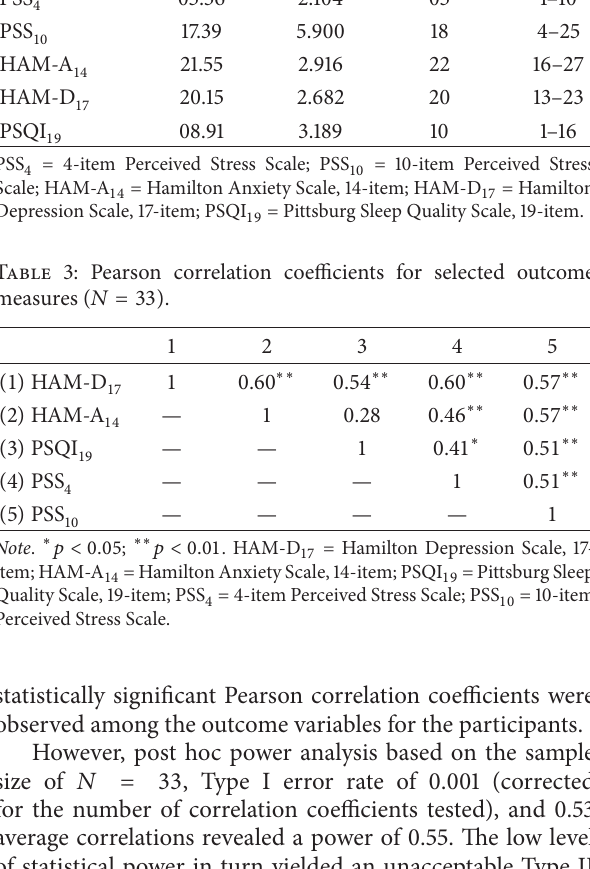
Table 2: M, SD, Mdn, and range for instruments ( 𝑁 = 33 ). Instrument